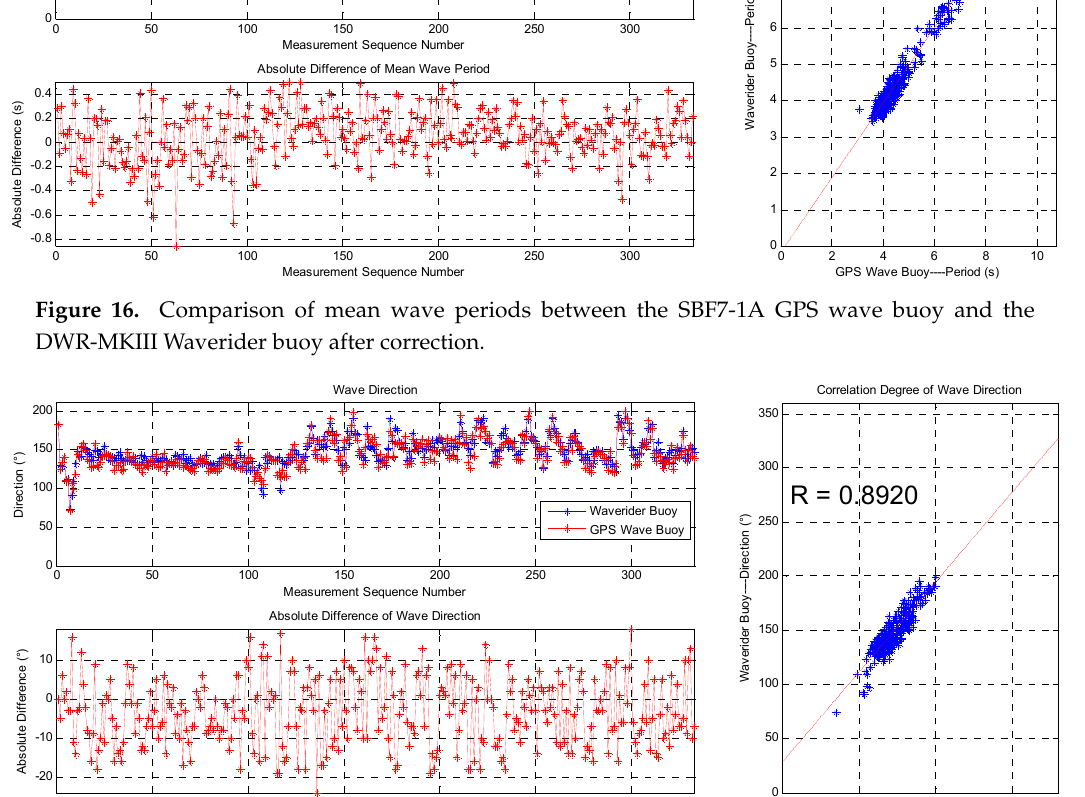
Figure 16. Comparison of mean wave periods between the SBF7-1A GPS wave buoy and the DWR- MKIII Waverider buoy after correction.